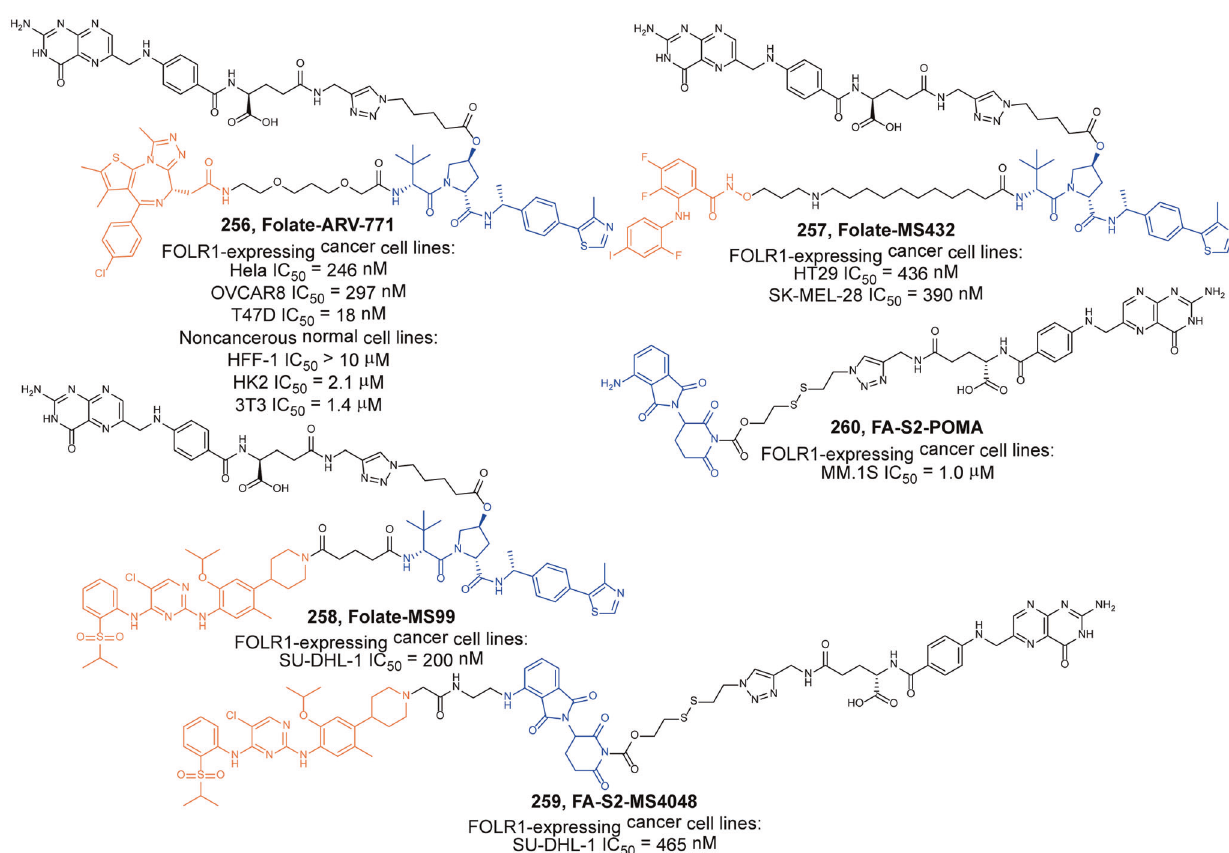
Fig. 85 The representative PROTACs of Folate-Caged PROTACs